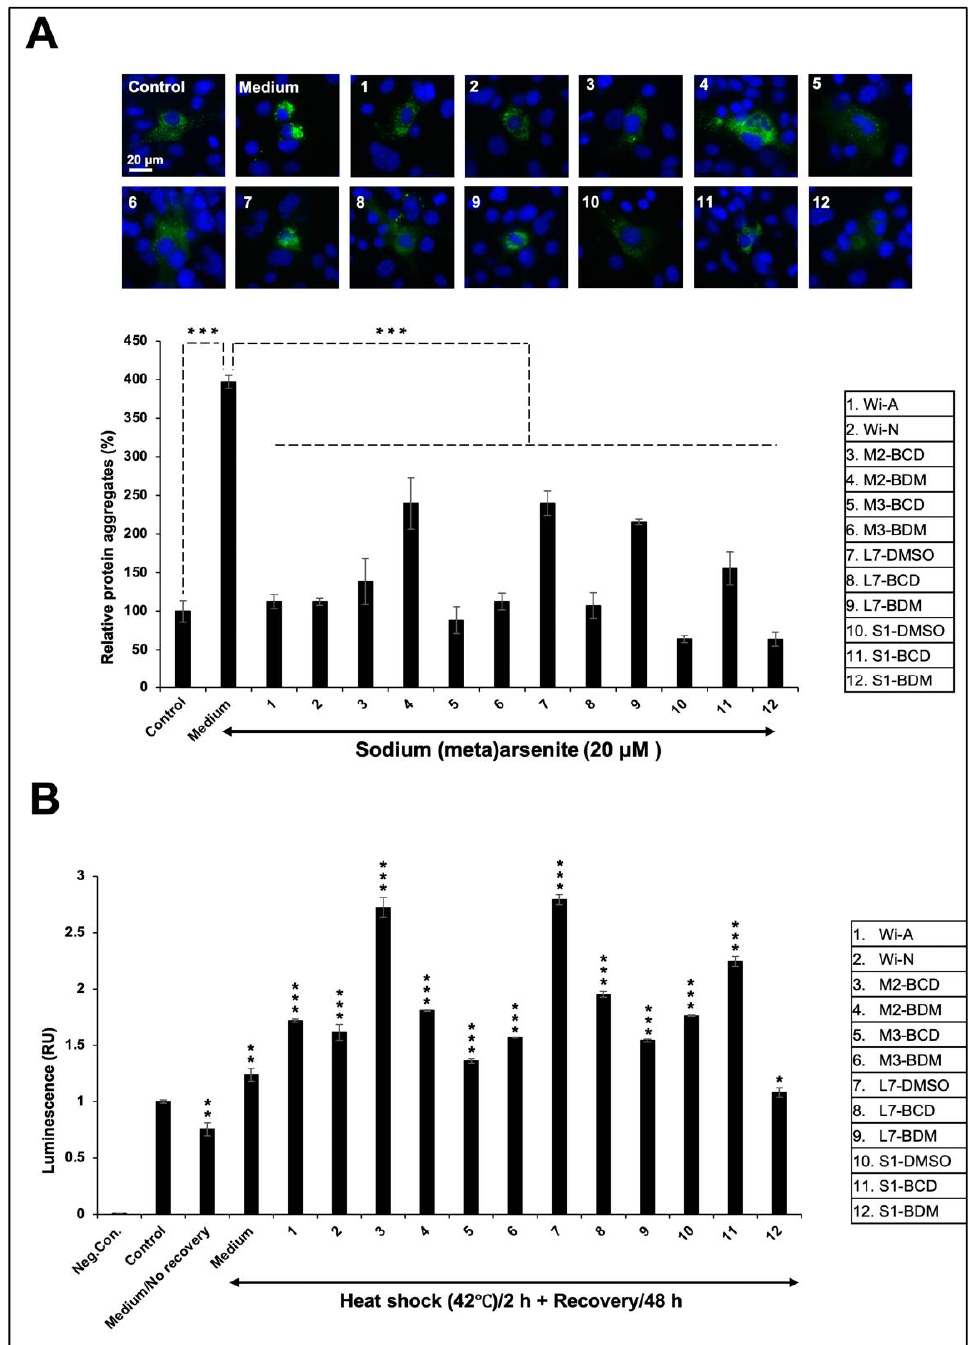
Figure 6. Effect of Ashwagandha extracts and purified withanolides on metal and heat-shock-induced protein aggrega- tion. ( A ) Protein aggregation and deaggregation assay showing the GFP aggregation in sodium-(meta)arsenite-treated cells and deaggregation after incubation with Ashwagandha withanolides. ( B ) Luciferase activity in heat-shock was treated and recovered either in control or Ashwagandha-withanolides-supplemented medium. Quantitation of the results is shown below (mean ± SD, n = 3), * p < 0.05, ** p < 0.01, *** p < 0.001 (Student’s t